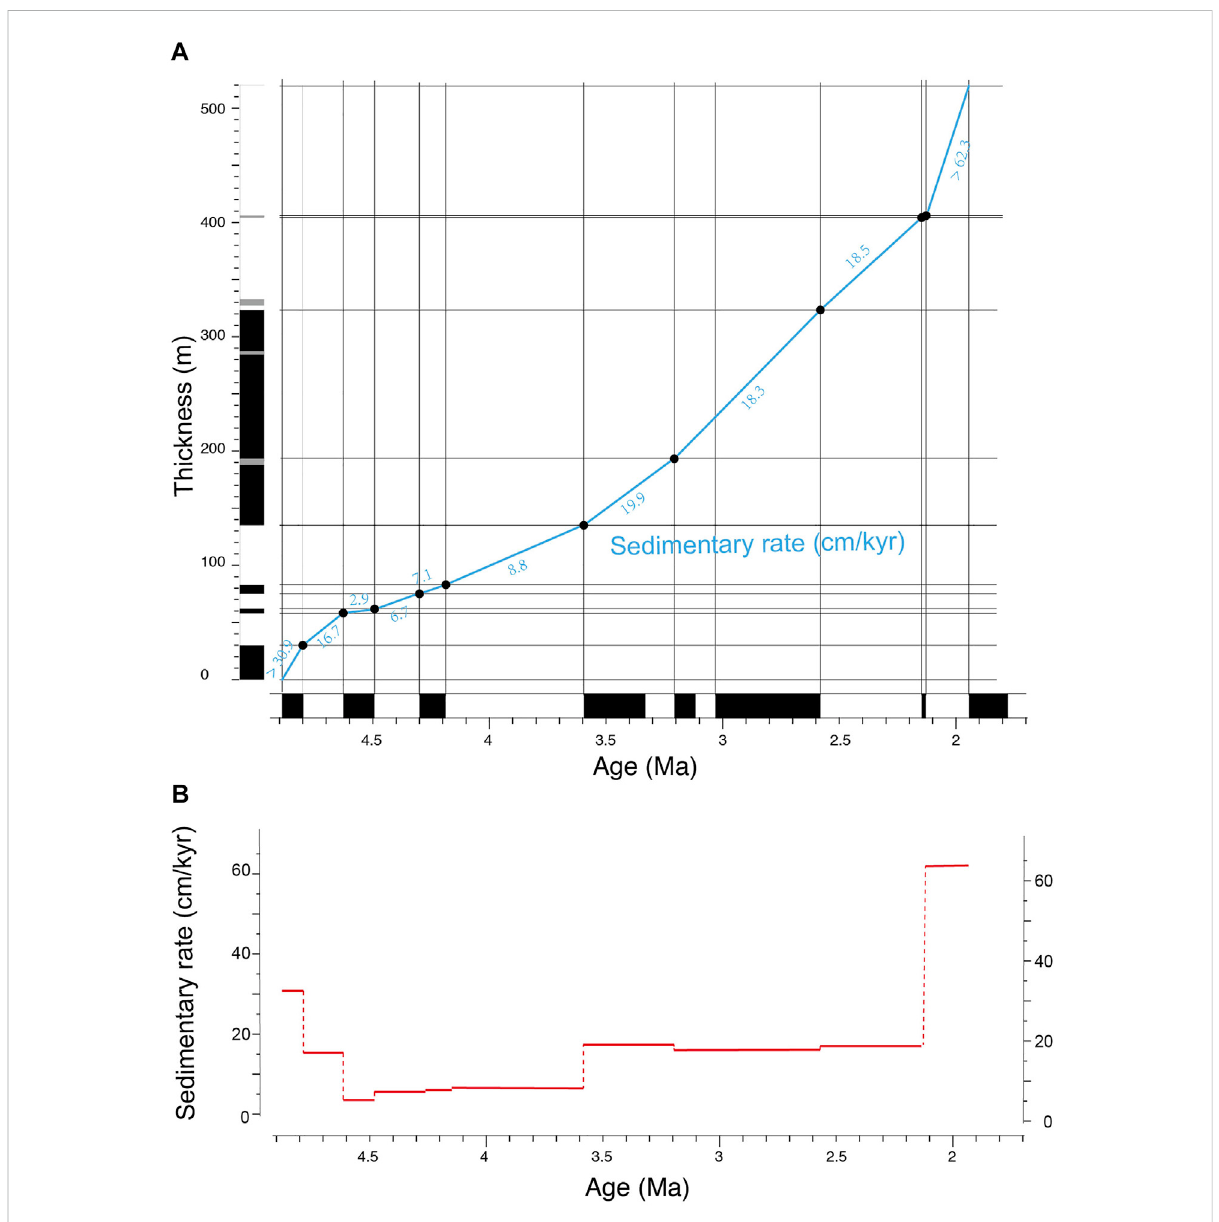
FIGURE 10 The stratigraphic height as a function of magnetostratigraphic age in the Yengisar succession of the western Tarim Basin showing sedimentation rates in the studied section. (A) Plot of the sedimentary thickness versus time; (B) Plot of sedimentary rate variation over